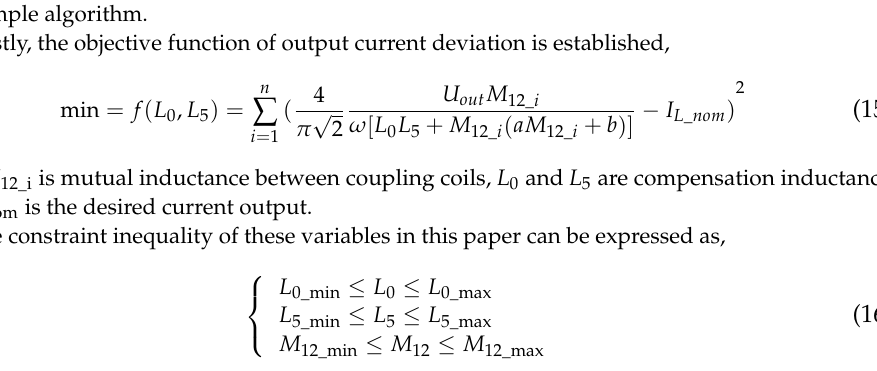
Figure 8. Current output of the hybrid IPT system with the PSO parameters. 4. Experiment Verification With the designed experimental parameters in Table 1, a 200 W hybrid topology wireless charging platform was built, as shown in Figure 9. The DC input voltage was 70 V, and the coefficient a and b of M 12 and M 34 was 0.52 and 2.17 uH, respectively. The hy- brid IPT system operated with a fixed frequency at 85 kHz to validate the performance of the proposed method under misalignment conditions.